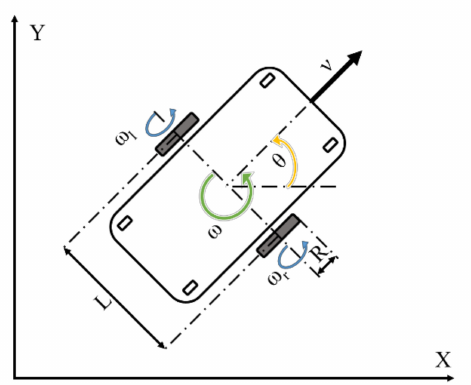
Figure 2. Kinematic model of a di ff erential drive mobile robot